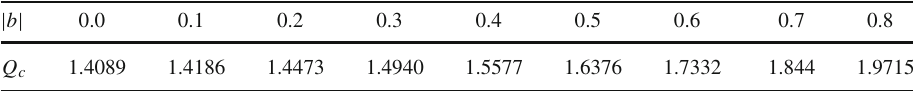
Table 1 The results of the critical electric charge Q c with different values of the LNE parameters b . Here, we set m 2 = − 15 , q = 2 and r + = 4